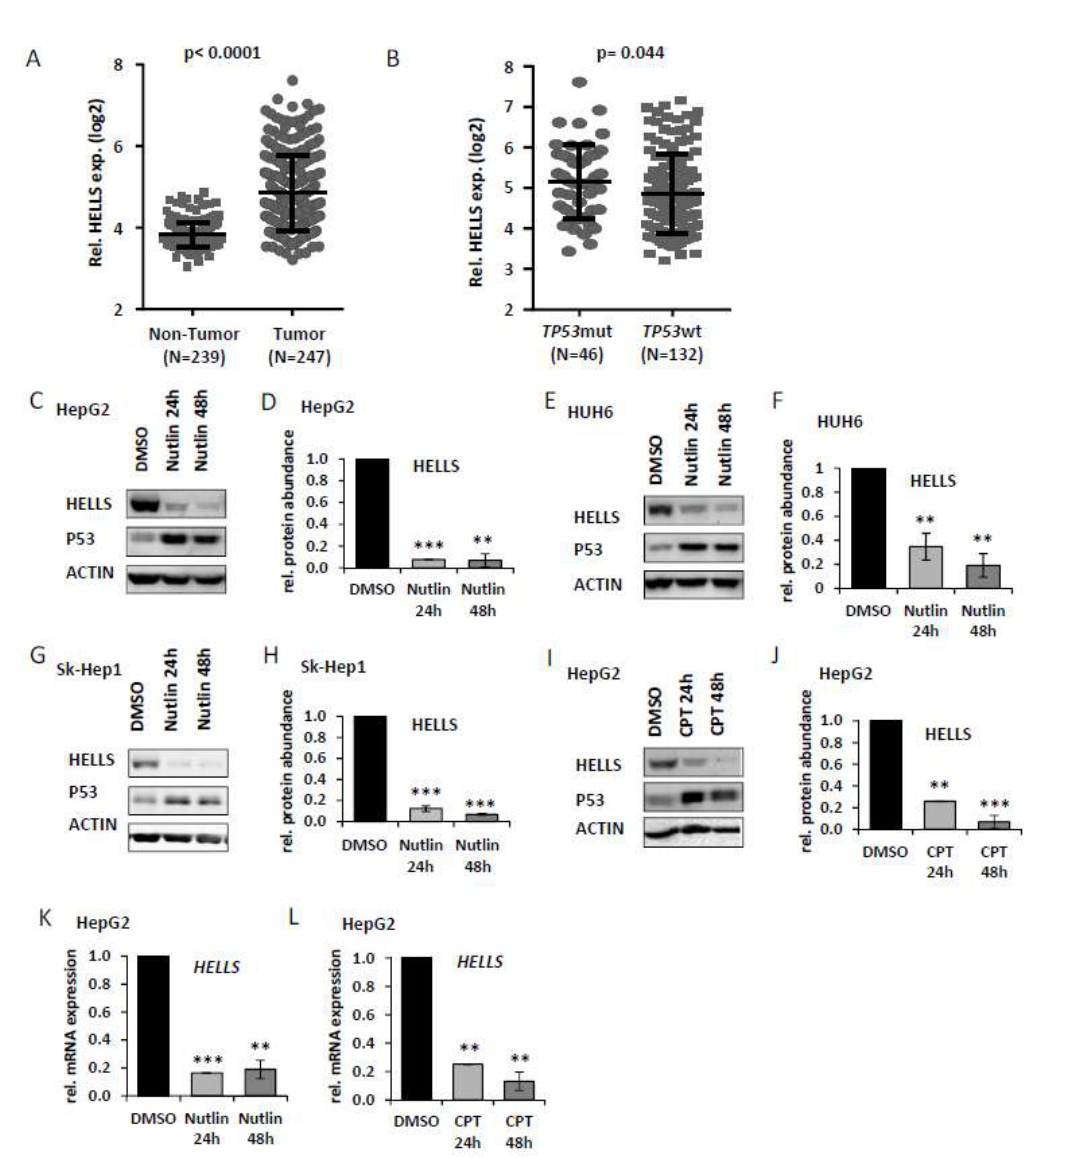
Figure 1. HELLS expression levels are down regulated after P53 induction: ( A ) HELLS expression in hepatocellular carcinoma (HCC, Tumor) and matching non-tumorous tissue (NT). ( B ) HELLS expression in HCC harboring either wildtype (wt) or mutated (mut) TP53 . Analysis of the data set has been performed as previously published by Roessler et al. [30]. Statistical significance was determined using the Mann-Whitney test. p -values ≤ 0.05 were considered significant. ( C ) HepG2 cells were treated with DMSO or Nutlin-3a for 24 h or 48 h. Cell extracts were analyzed by immunoblotting with indicated antibodies. ( D ) Relative densitometric quantification of immunoblots derived from three independent experiments and normalized to the DMSO control as described in ( C ). ( E , F ) HUH6 cells treated as described in ( C , D ). ( G , H ) Sk-Hep1 cells treated as described in ( C , D ). ( I ) HepG2 cells were treated with DMSO or CPT for 24 h or 48 h. Cell extracts were analyzed by immunoblotting with indicated antibodies. ( J ) Relative densitometric quantification of immunoblots derived from three independent experiments and normalized to the DMSO control as described in ( I ). ( K ) HepG2 cells were treated with DMSO or Nutlin-3a for 24 h or 48 h. HELLS mRNA was quantified by qRT-PCR. Standard deviations are derived from three biological replicates. ( L ) HepG2 cells were treated with DMSO or CPT for 24 h or 48 h. HELLS mRNA was quantified by qRT-PCR. Standard deviations are derived from three biological replicates. ** p < 0.01, *** p < 0.001 (Student’s t -test). Data are presented as mean ±